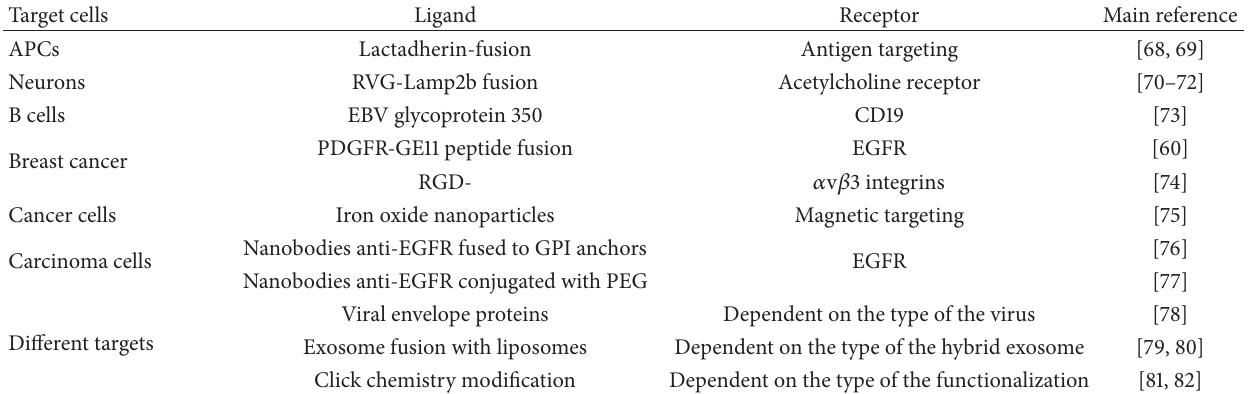
Table 2: Extracellular vesicles targeting